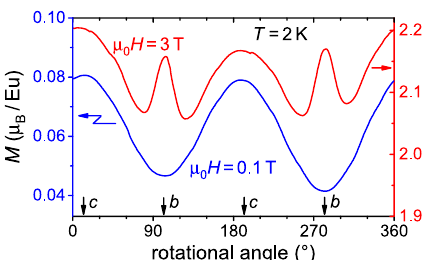
Figure 3. Magnetization in dependence on sample orientation with respect to H for two applied fields ( µ 0 H = 0.1 T, 3 T) below and above µ 0 H m ≈ 2.2 T at T = 2 K. The sample is rotated in the b – c plane, i.e. around the a -axis, with the alignment of the respective axis with H marked by